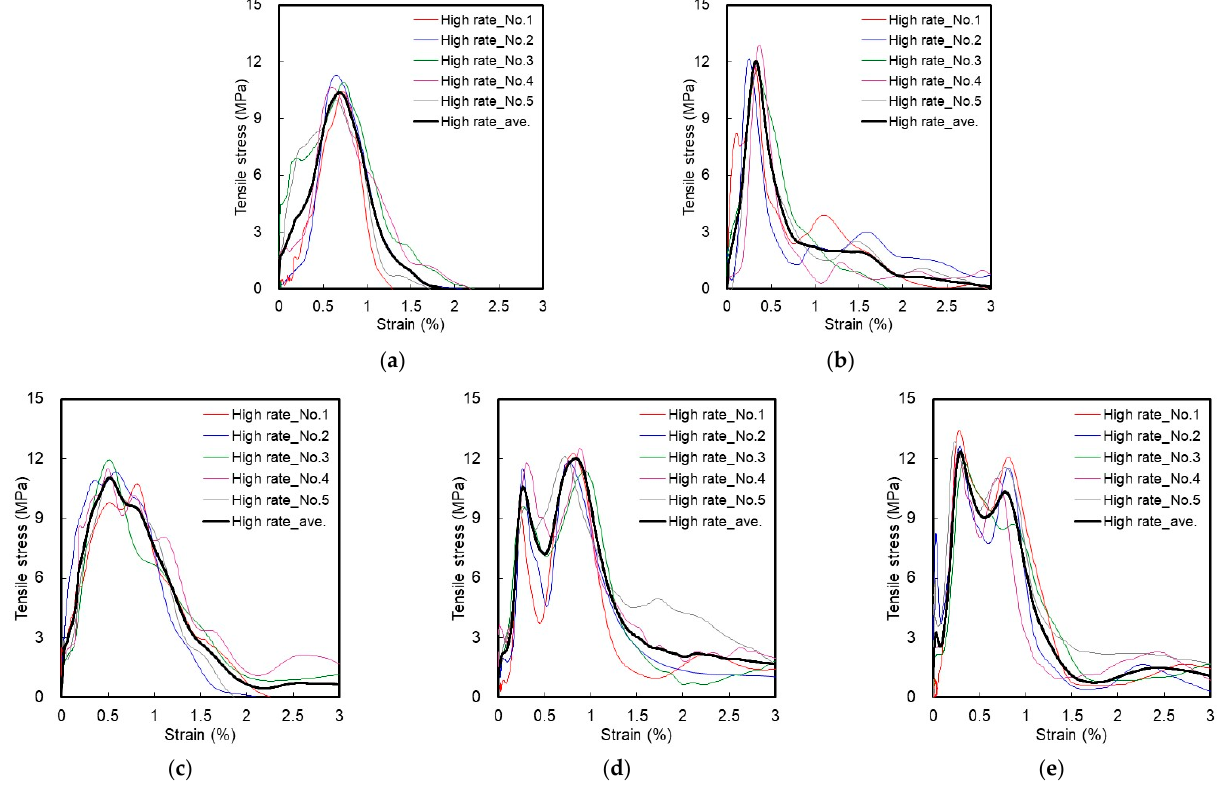
Figure 7. Tensile stress–strain curve at the high rate: ( a ) H2.0; ( b ) S2.0; ( c ) H1.5S0.5; ( d ) H1.0S1.0; ( e ) H0.5S1.5. The multiple cracking patterns of the HPFRCC are shown in Figure 8. The tensile properties of HP-MFRCC and HP-HFRCC are summarized in Tables 5 and 6, respectively.